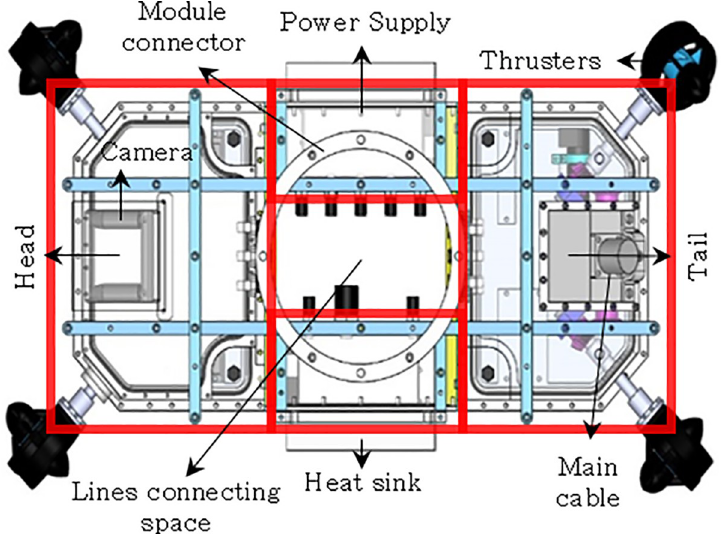
Fig 2. Structure diagram of an underwater robot with tilting thrusters for redundant actuation